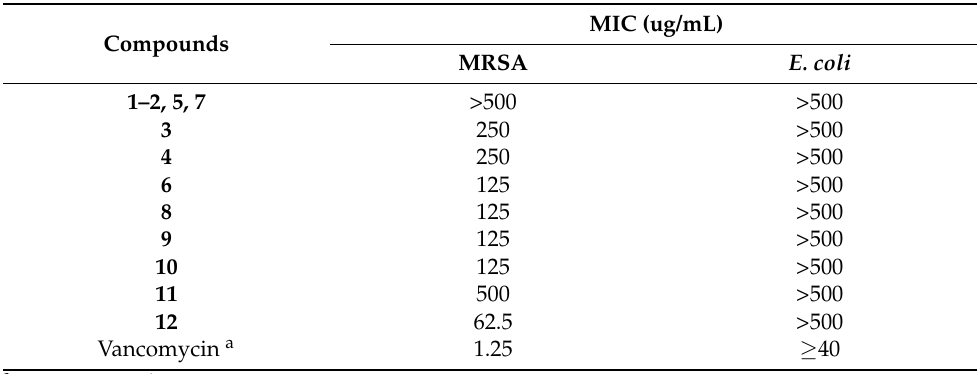
Table 3. Antimicrobial activities of compounds 1–12 .